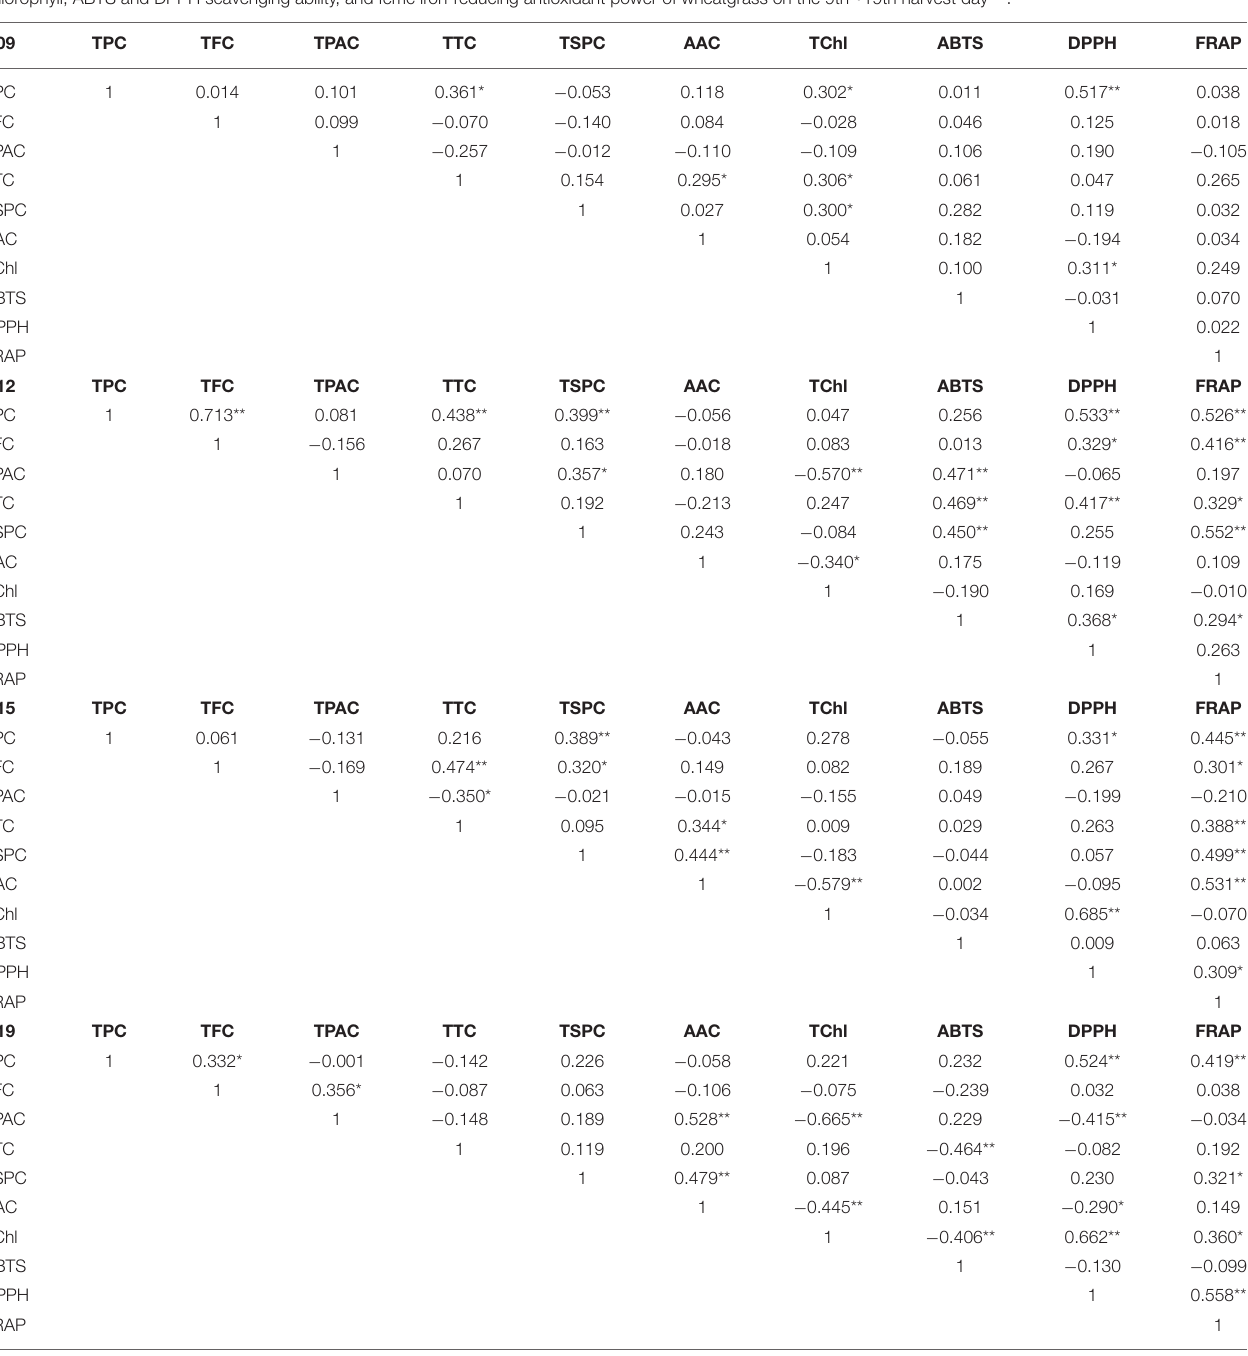
TABLE 2 | Correlation coefficients of total polyphenols, total flavonoids, total proanthocyanins, total triterpenes, total soluble polysaccharides, ascorbic acid, total chlorophyll, ABTS and DPPH scavenging ability, and ferric iron-reducing antioxidant power of wheatgrass on the 9th ∼ 19th harvest day a,b